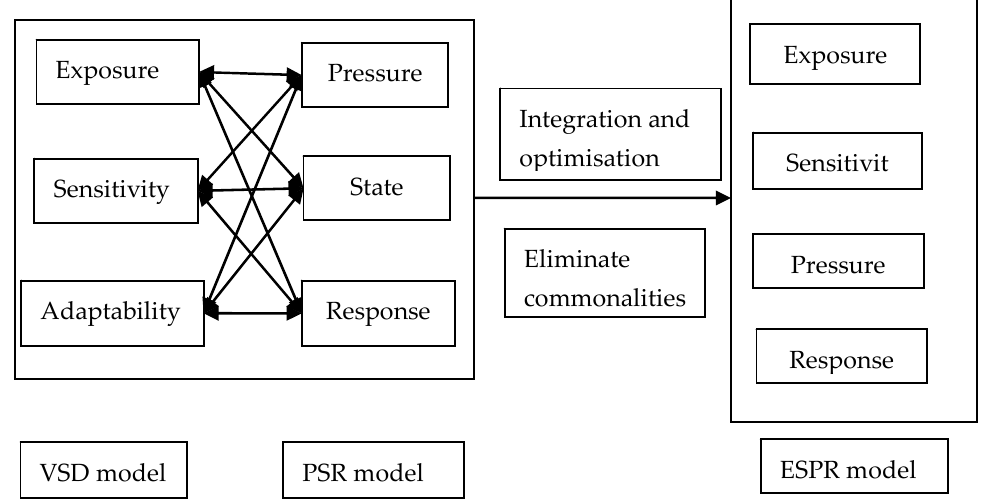
Figure 2. Construction of ESPR Model.